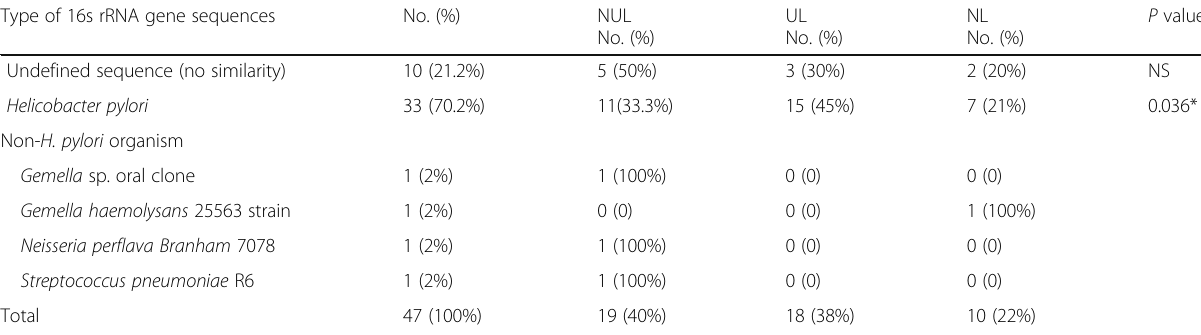
Table 1 Sequence blast of PCR products amplified from gastric biopsies and its distribution among endoscopic lesions of 47 studied patients